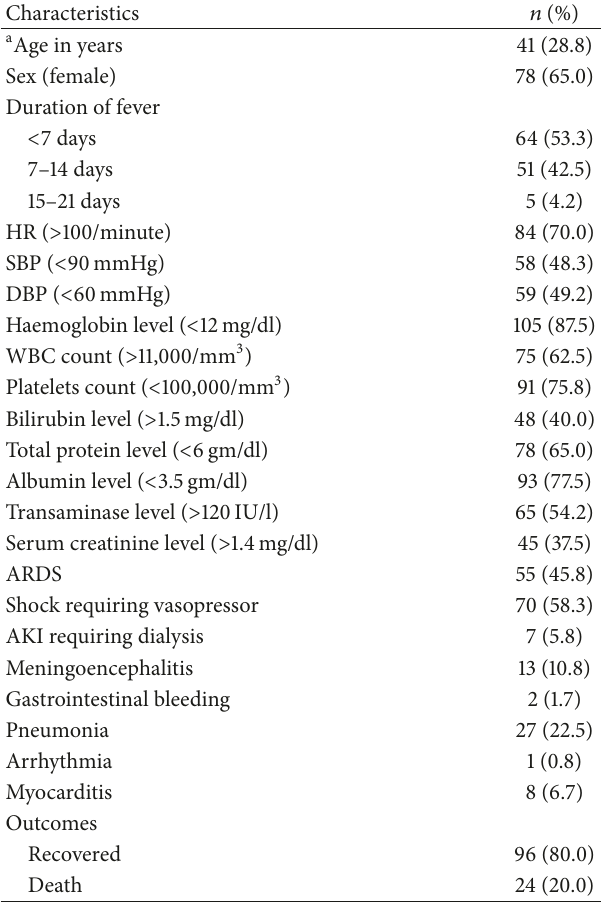
Table 1: Baseline characteristics ( 𝑛 = 120